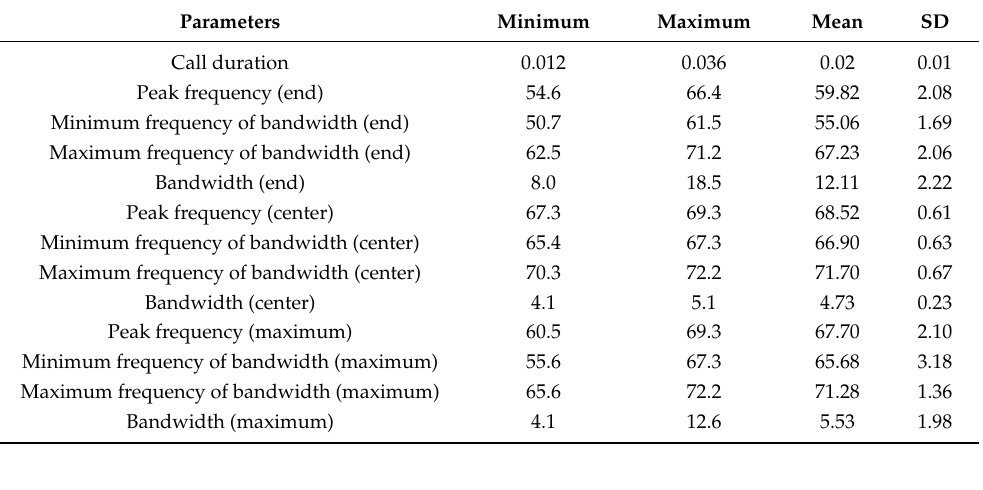
Table 2. Description of acoustic parameters of echolocation calls used in the individual recognition experiment on Rhinolophus ferrumequinum .